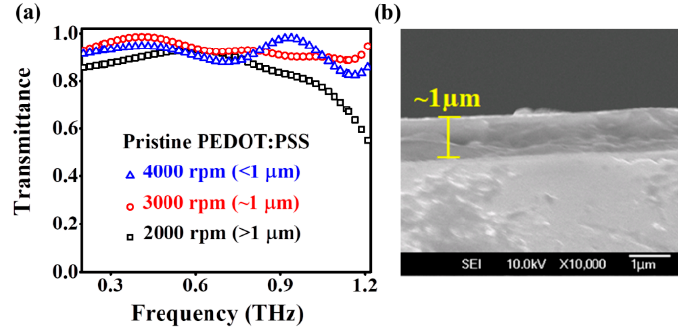
Figure 3. ( a ) THz transmittance of pristine PEDOT: PSS layers with three different thicknesses controlled by the rotation speed of the spin coater and ( b ) FESEM cross-sectional image of the 1 µ m thick pristine PEDOT: PSS layer deposited on clean substrate by spin coating with a rotation speed of 3000 rpm for 30 sec.